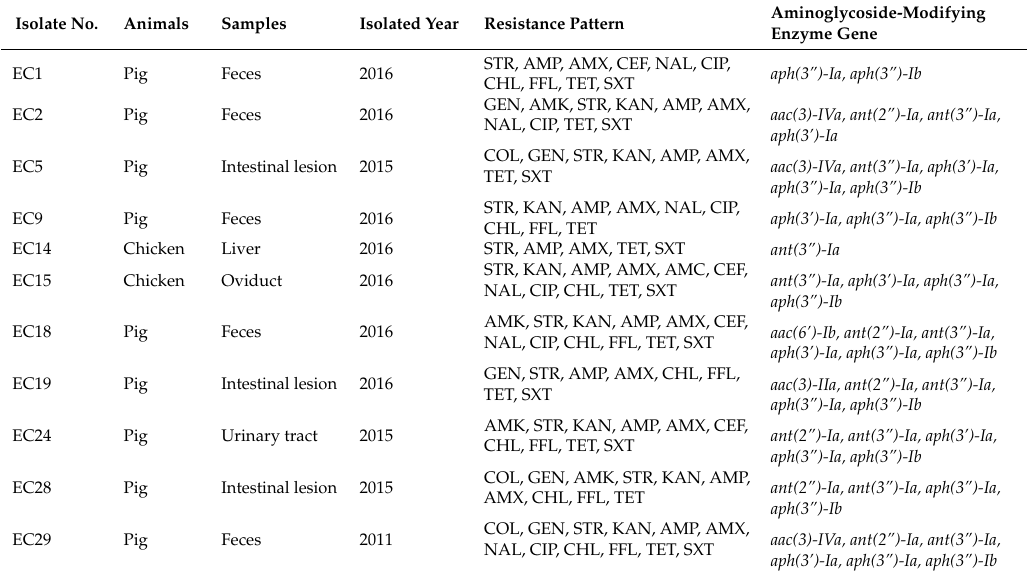
Table 1. Characteristics of the E. coli isolates used in this study.